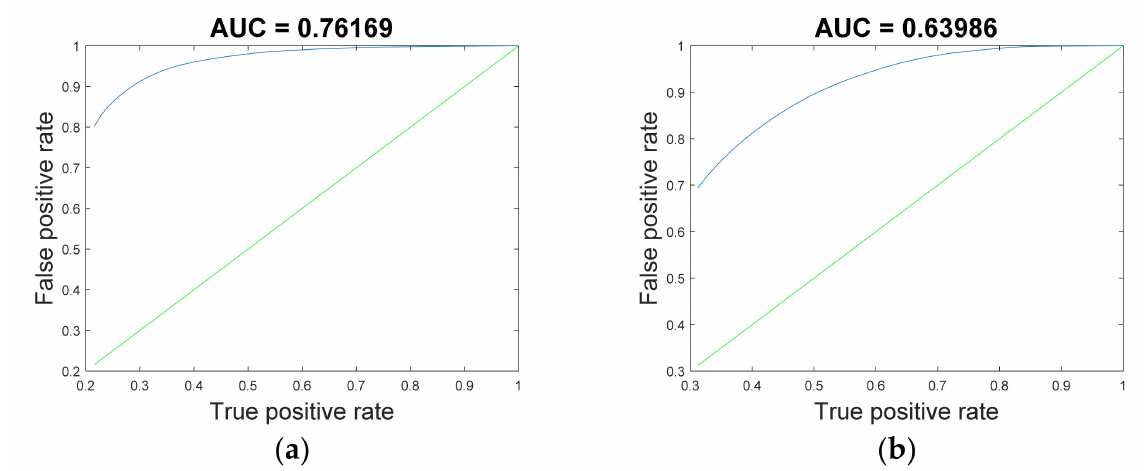
Figure 14. Receiver operating characteristic curve of RF in the cross-subject experiment. ( a ) Random- NBI; ( b )